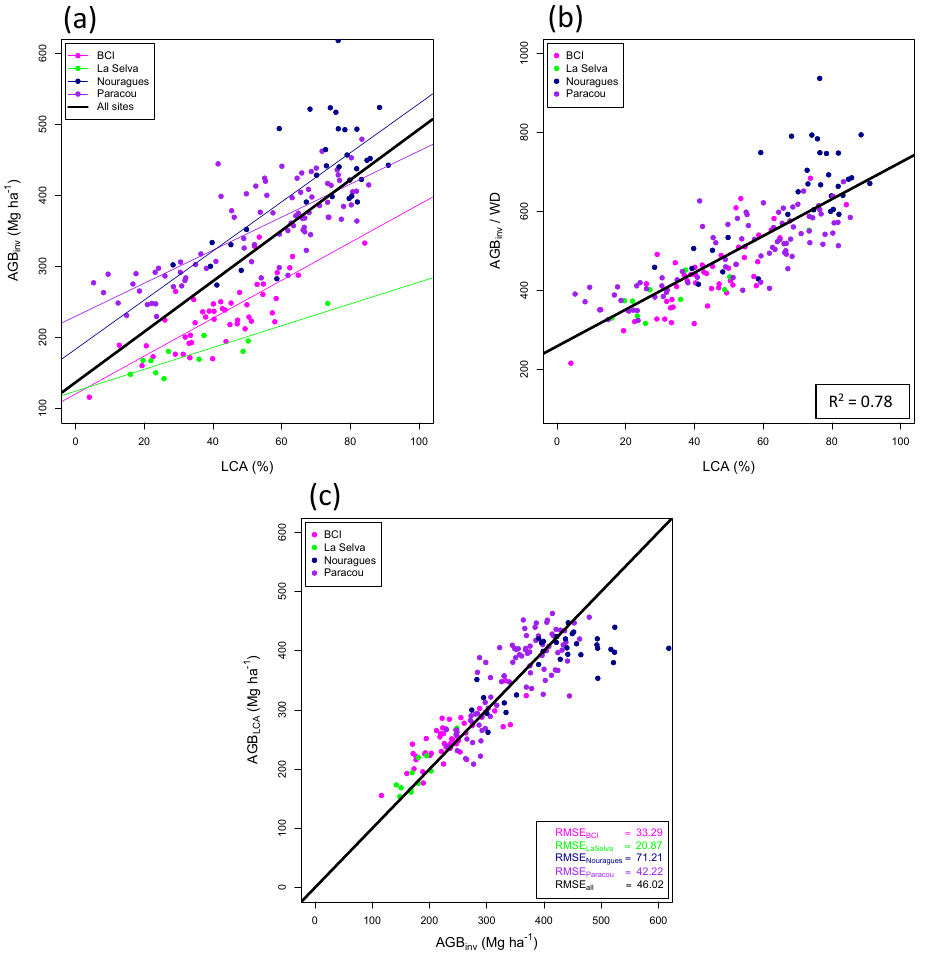
Figure 4. Relationship between AGB inv and LCA (a) , AGB inv normalized by averaged wood density (WD) (b) and AGB inv vs. AGB LCA estimated with the LCA_wd model (c) . The black line represents the one-to-one line. Normalizing AGB by averaged wood density (WD) brings the data from different sites closer to a common